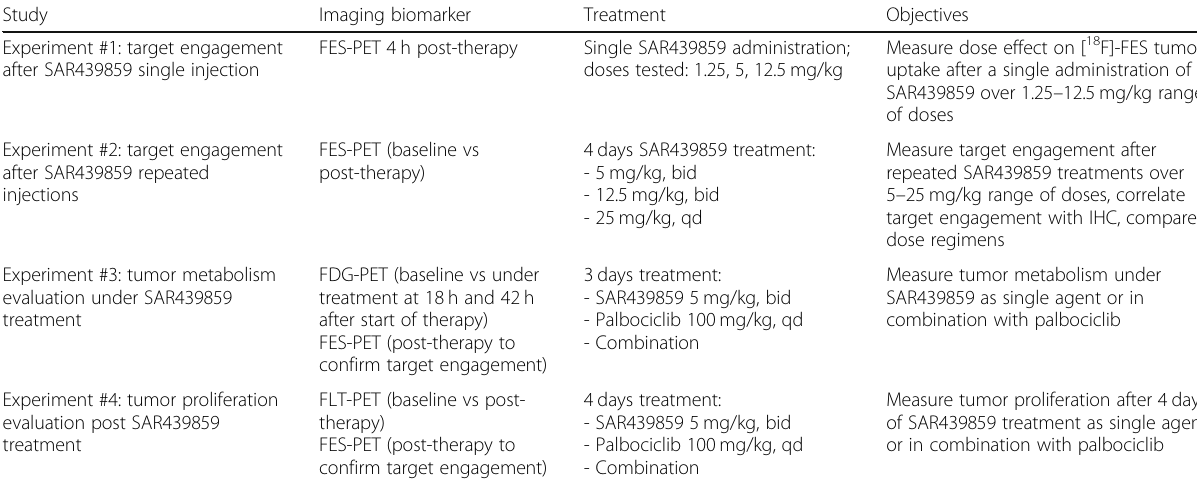
Study Imaging biomarker Treatment Experiment #1: target engagement after SAR439859 single injection